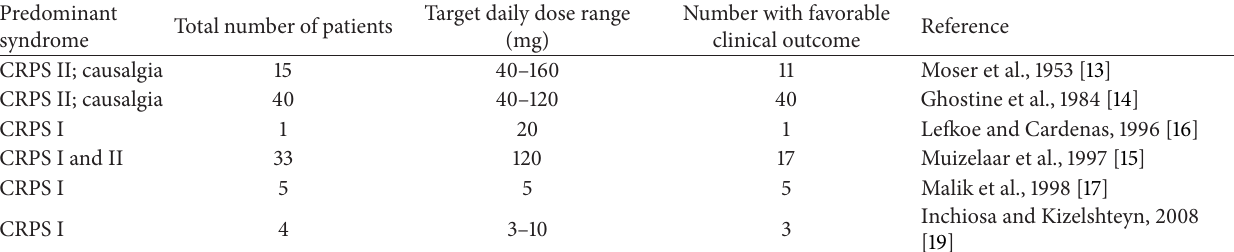
Table 1: Summary of clinical trials of phenoxybenzamine for treatment of CRPS.